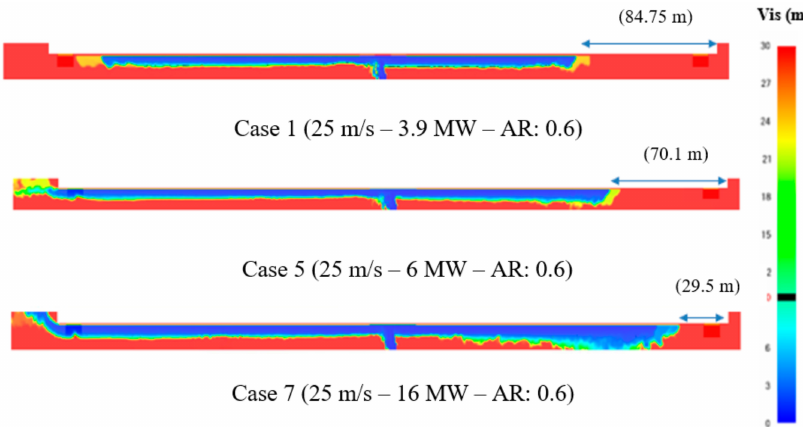
Figure 8. Visibility in the tunnel fire when changing the HRR.